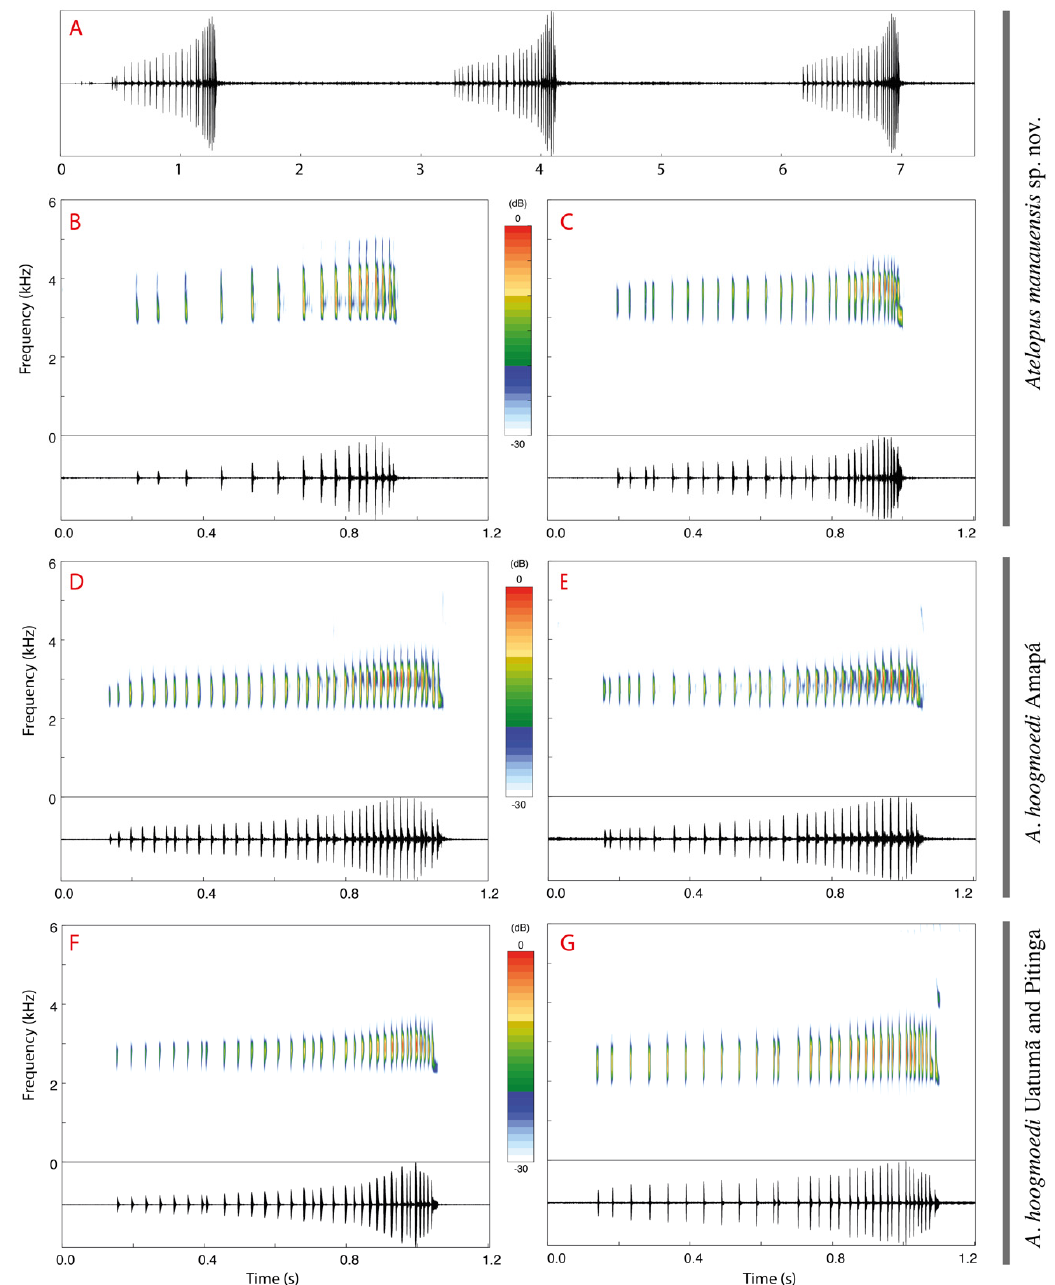
Figure 7. Advertisement call (type 1 call) of Atelopus manauensis sp. nov. and A . hoogmoedi of Amapá, of REBIO Uatumã, and of Pitinga River: ( A ) Oscillogram of three advertisement calls issued at regular intervals by an uncollected male of A . manauensis sp. nov. in Reserva Florestal Adolpho Ducke (RFAD), Manaus, Amazonas; ( B ) Spectrogram and oscillogram showing an advertisement call of the holotype and ( C ) another uncollected specimen of A . manauensis sp. nov. in RFAD; ( D , E ) Spectrograms and oscillograms of the advertisement calls of two specimens of A . hoogmoedi of Amapá described by Campos and Carvalho [50]; ( F , G ) Spectrograms and oscillograms of males of A . hoogmoedi of REBIO Uatumã ( F ) and Pitinga River ( G ), Amazonas. All localities are in Brazil .